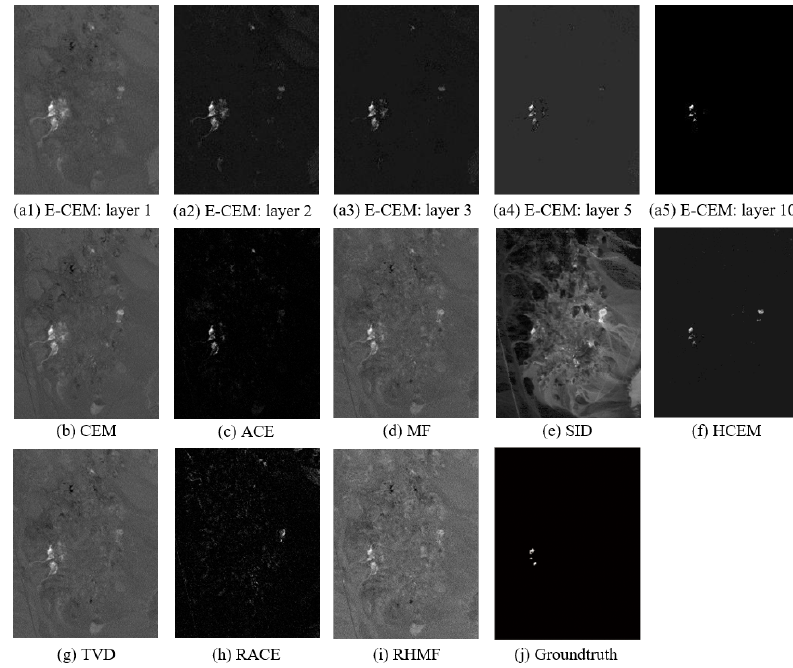
Figure 10. Detection outputs of different algorithms on the AVIRIS Cuprite data: First row ( a1 – a5 ): 1st, 2nd, 3rd, 5th and 10th layer of the E-CEM’s outputs. Second row and third row ( b – i ): results of CEM [2], ACE [10], MF [11], SID [9], HCEM [17], TVD [15], RACE [37], RHMF [16] and the proposed E-CEM. ( j ): ground truth. All outputs are normalized to [ 0,1 ]